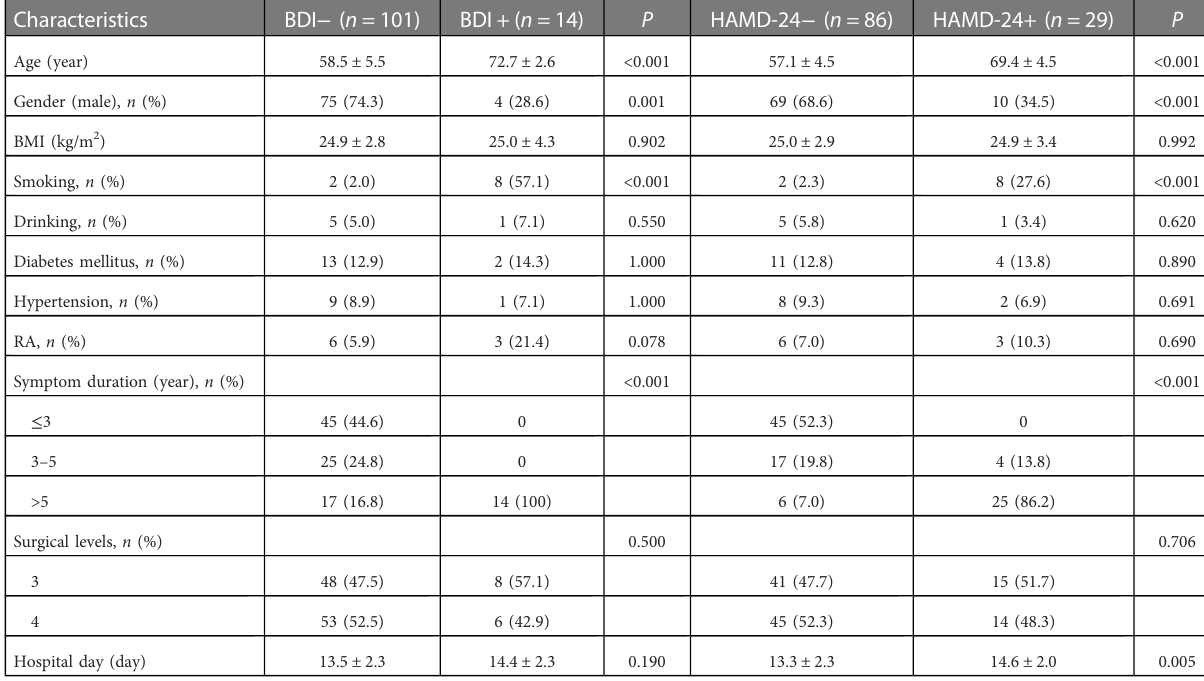
TABLE 1 Characteristics statistics of cohort by BDI and HAMD-24.